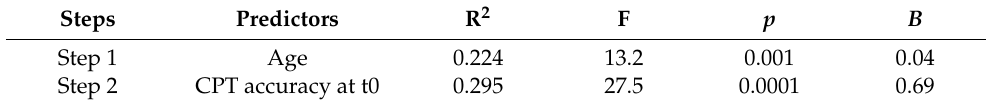
Table 4. Hierarchical linear regression model predicting CPT accuracy at t1 after MPH administration.